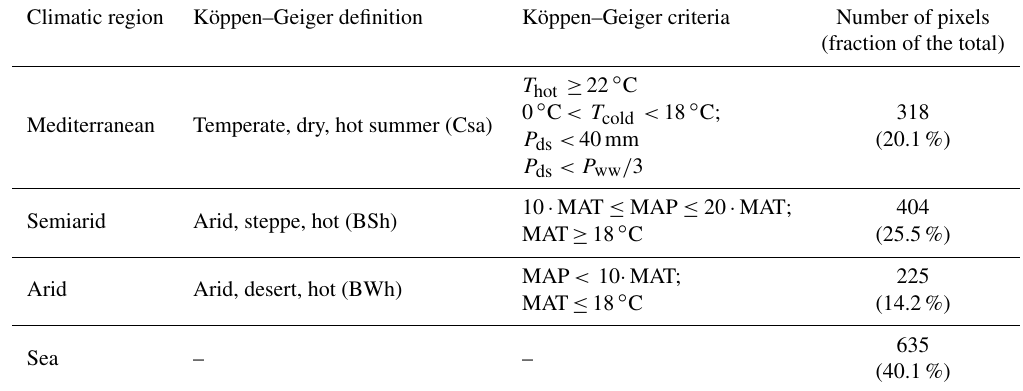
Figure 1. Map of the study area showing terrain elevation, climatic classification from Srebro and Soffer (2011), location of the radar, and rain gauges used in the study. The small map shows the location of the study area within the eastern Mediterranean. Table 1. Köppen–Geiger classification (Peel et al., 2007; Srebro and Soffer, 2011) and number of pixels analysed for each climatic region according to the Köppen–Geiger classification. MAT: mean annual temperature; MAP: mean annual precipitation; T hot : temperature of the hottest month; T cold : temperature of the coldest month; P ds : precipitation of the driest month in summer; P ww : precipitation of the wettest month in